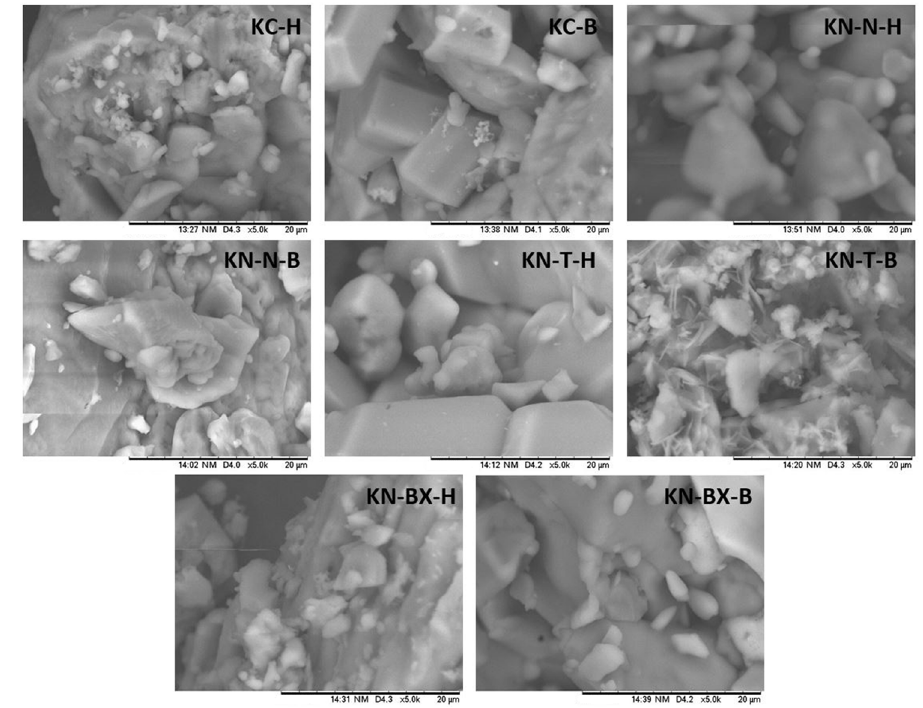
Figure 2: SEM morphologies of the highest XRD scored synthesized